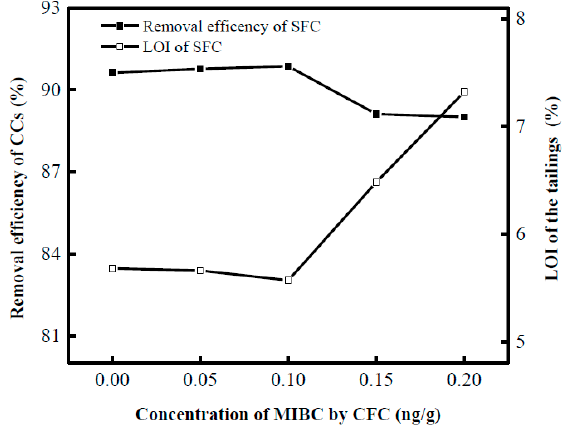
Figure 5. Effect of MIBC concentration on decarburization by CFC: kerosene = 3 g/kg·ash, Tween 80 = 5% of the kerosene dosage, slurry concentration = 100 g/L, and pump speed = 2000 r/min.